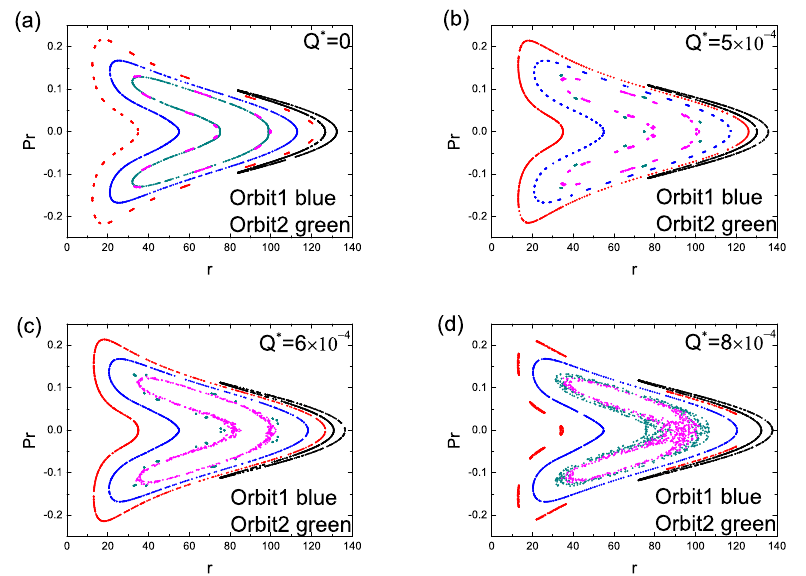
Figure 6. Same as Figure 5c but the inductive charge parameters Q ∗ are different. There is no chaos in ( a , b ). Chaos occurs for the pink orbit with the initial separation r = 100 in ( c ). Orbit 2 and the pink orbit with the initial separation r = 100 are chaotic in ( d